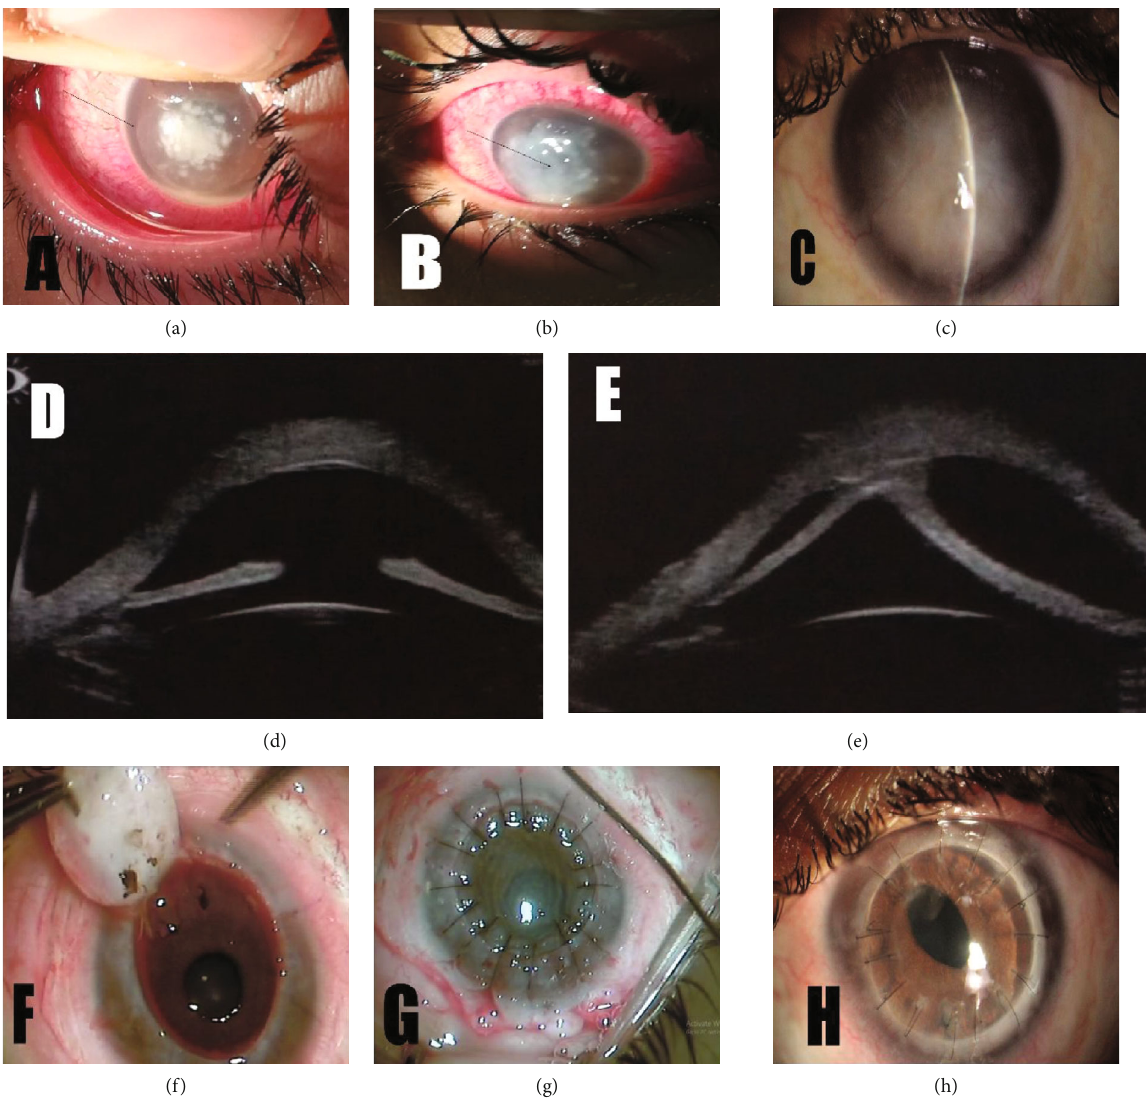
Figure 2: (a) Slit-lamp photo of case #5 at 1 st visit showing ciliary injection, central dense interface in fi ltrates with peripheral satellites within the edge of the fl ap (arrow) and hypopyon. (b) Slit-lamp photo 48 hours after fl ap amputation and 2 nd intrastromal amphotericin injection showing di ff use dense in fi ltrate with evolving descemetocele (arrow). (c) Slit-lamp photo, 3 weeks after sutures removal, showing: quiet eye, epithelialized cornea, stroma fi lled with amniotic membrane, and formed anterior chamber (AC). (d) Ultrabiomicrosopic (UBM) image of anterior segment showing: restored corneal thickness and formed AC. (e) UBM image of anterior segment showing inferior peripheral anterior synechia (PAS). (f, g) Intraoperative pictures captured during penetrating keratoplasty (PK) showing removal of the trephined cornea and release of the PAS at 6 o ’ clock position (f), corneal graft secured with interrupted 10/0 nylon sutures (g). (h) Slit-lamp photos 5 months after PK showing clear and healthy corneal